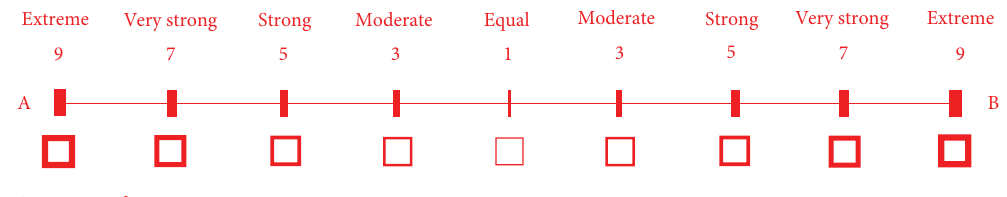
Figure 4: The scale of importance intensity for pairwise comparison.